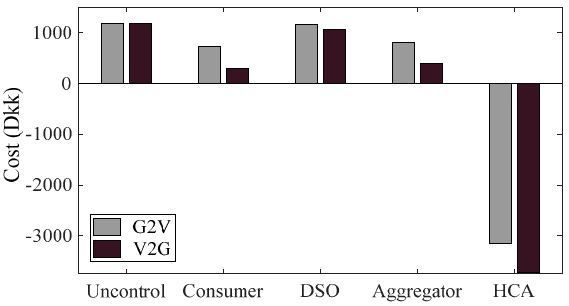
Figure 12. EV charging/discharging cost during various cases.